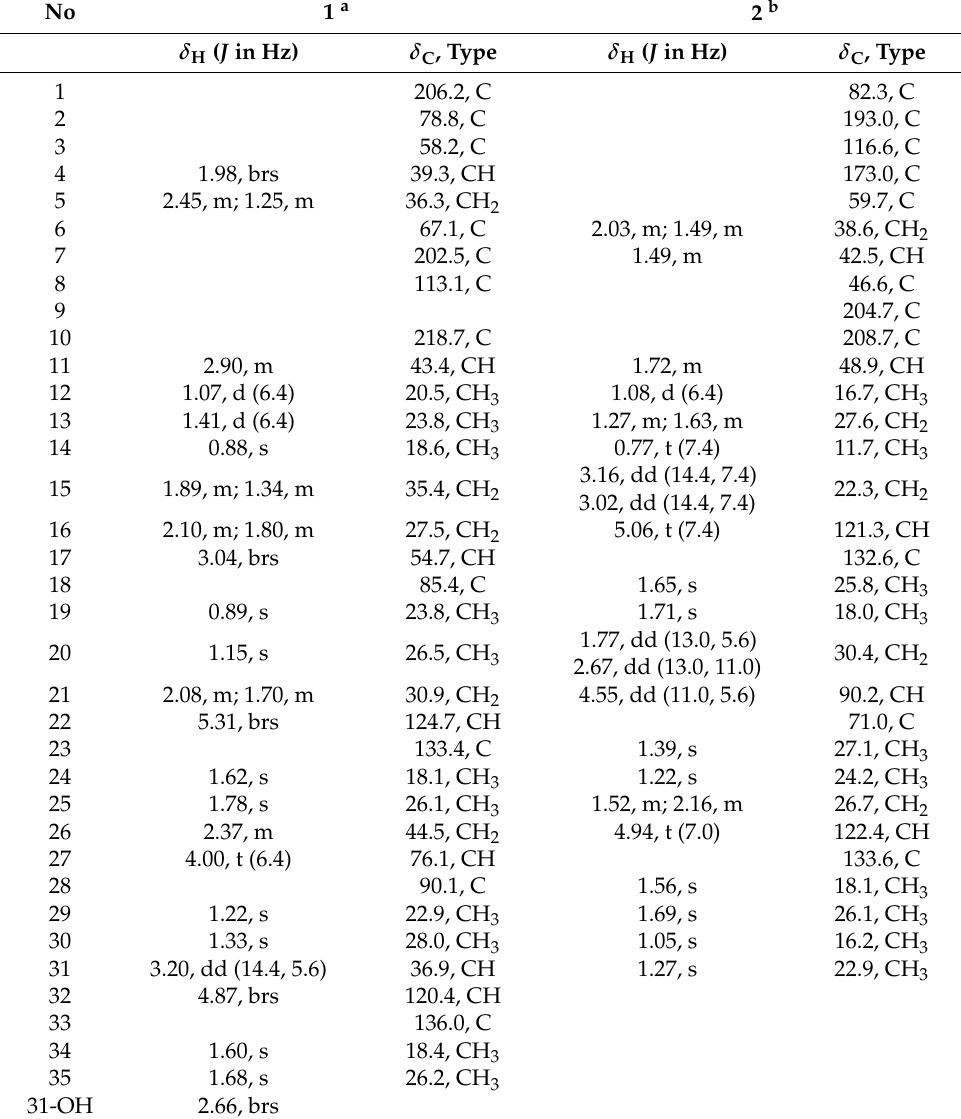
Table 1. 1 H NMR and 13 C NMR data for compounds 1 – 2 .